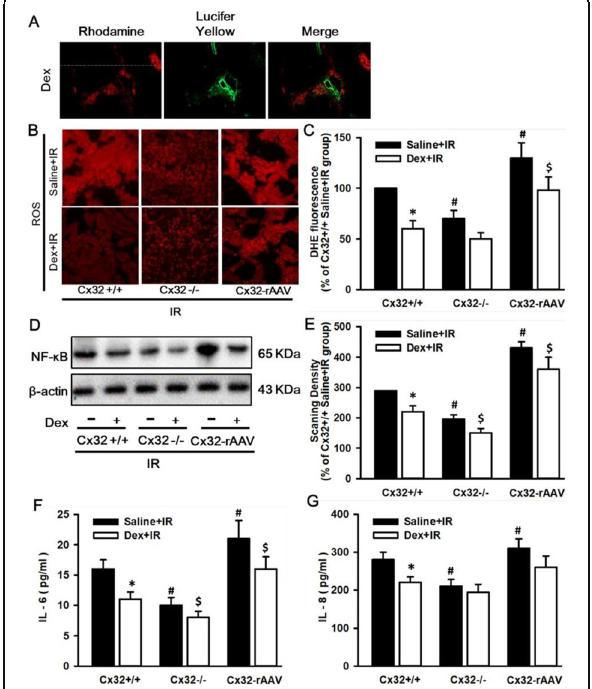
Fig. 4 (abstract 000565). Effects of Dexmedetomidine on ROS/ NF- κ B axis-mediated senescent bystander effect